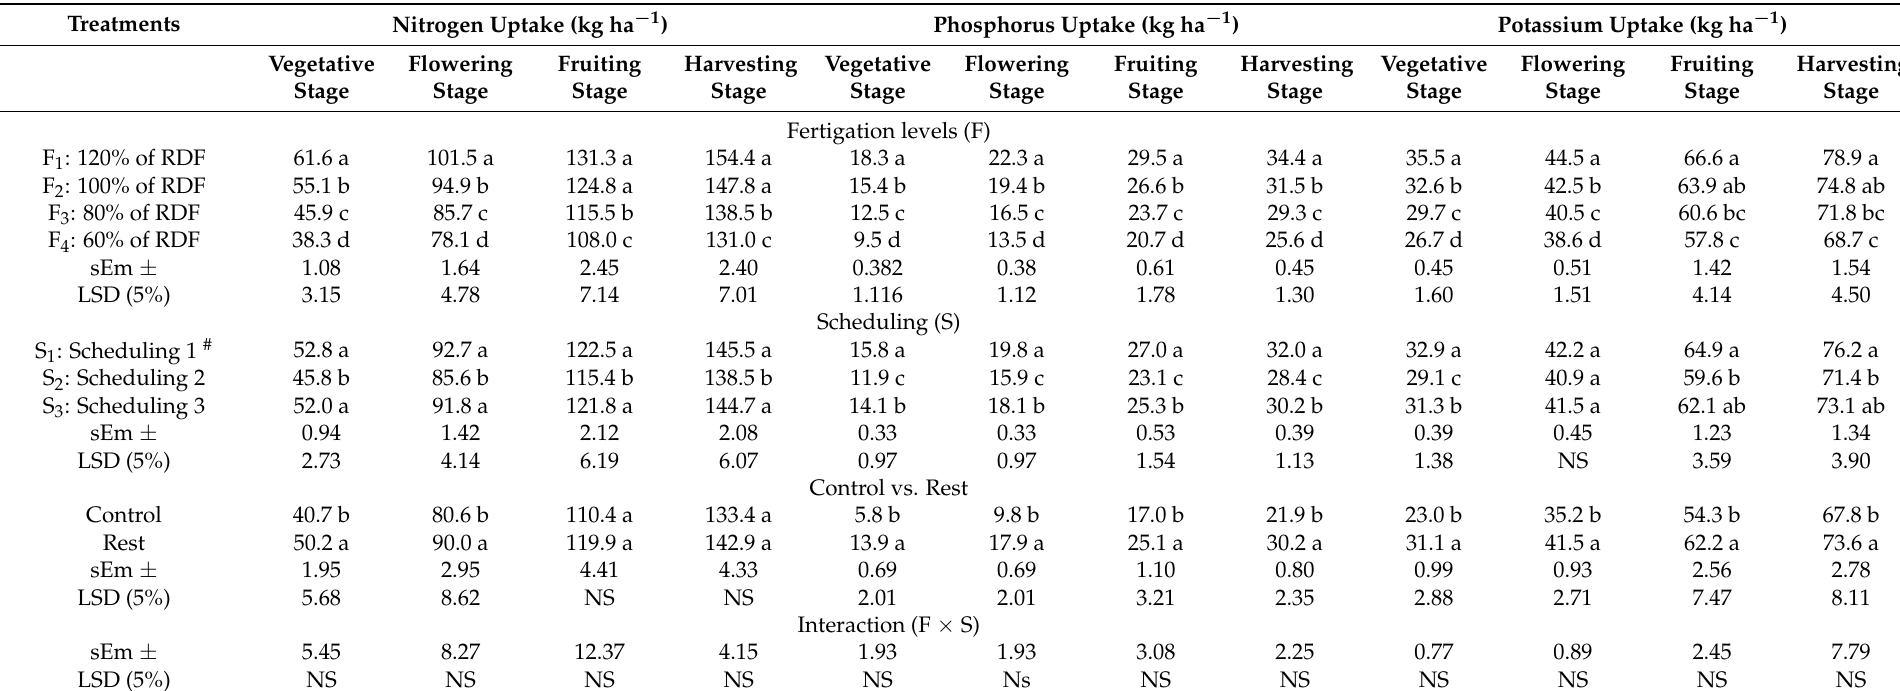
Table 7. Uptake of nitrogen, phosphorus, and potassium in tomato plants at different stages of plant growth (2-years pool data).